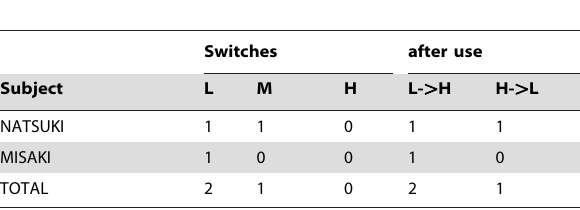
Table 6. Number of total switches observed as a function of hammer weight (L =300 g, M=600 g, H=1200 g) and the direction of switches (L- . H =from lighter to a heavier; H- . L=from heavier to lighter) in Experiment 2.